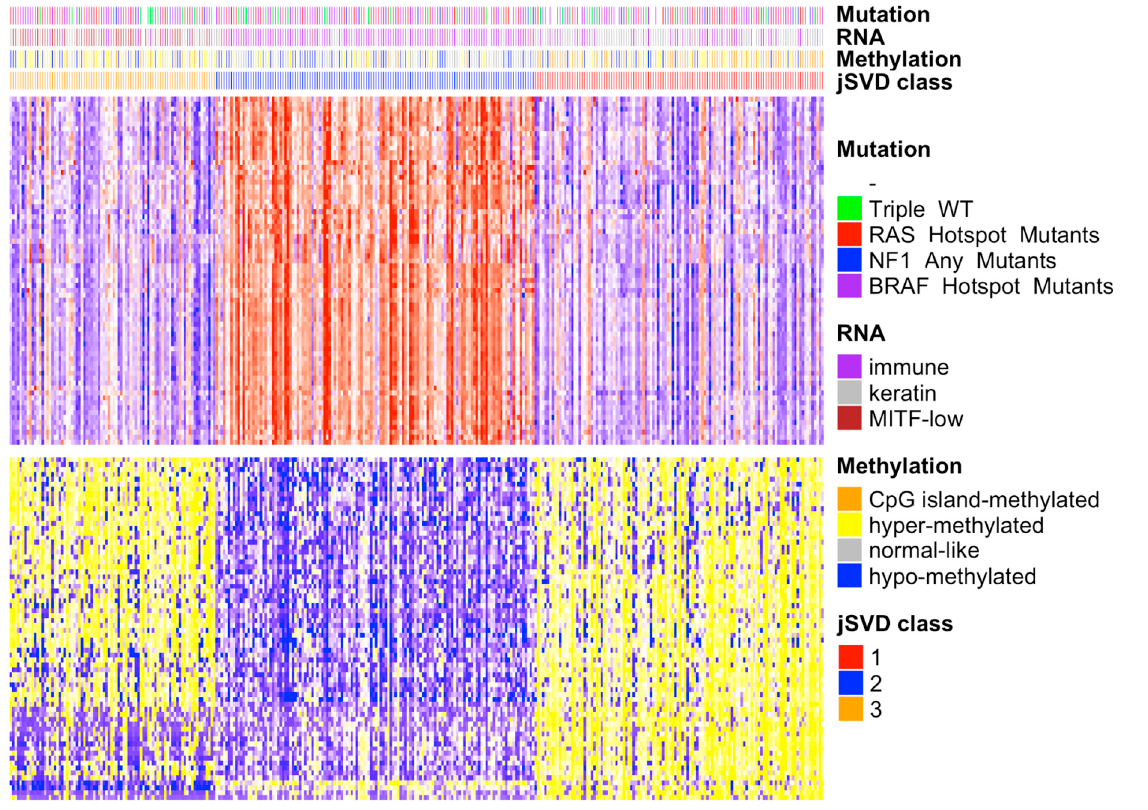
Figure 1. Heatmap of differentially expressed genes and methylation probes in the 3 jSVD classes. On the right is the legend of the four bars representing the TCGA SKCM somatic driver mutations, RNA and DNA methylation classes, and jSVD classes. The heatmap on top represents the RNA expression data; the gene expression is represented according to the mean values, with above mean values in red, below mean in blue, and at the mean in white; the intensity reflects the distance from the mean. The bottom heatmap shows the intensities of the DNA methylation probes; the colors range from yellow (hypermethylated, above mean) to blue (downmethylated, below mean). The bars above the heatmaps show information on the tumors obtained from the TCGA, including somatic mutation types (mutations of RAS, NF1, BRAF, or of none of these genes, triple wild-type), RNA clusters (immune, keratin, MITF-low), and methylation types (CpG island methylated, hypermethylated, normal-like, hypomethylated). Class 2 patients are enriched for immune RNA classes and normal-like methylation subtypes that were associated with better survival [14]. Cluster 1 is enriched in the CpG island methylated subtype, which was associated with the worst survival rate [14], as confirmed here (see Figure 2). Class 3 is enriched for hypermethylated and hypomethylated classes that